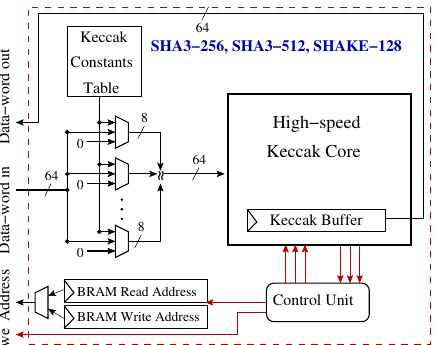
Figure 2: Unified architecture for SHA3-256, SHA3-512, and SHAKE-128. Control signals are shown in